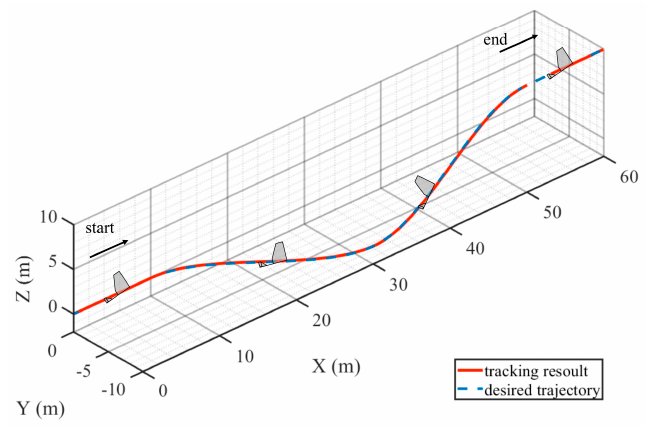
Figure 12. The 3D trajectory tracking results. From Figures 12 and 13, it can be seen that the tracking trajectory of the RAMPC matches the desired output trajectory very well. The maximum error in the X-axis and Z-axis displacement tracking is not more than 0.2 m, and the minimum error is in the X-axis tracking, with approximately 0.05 m, resulting in a great tracking effect. Figure 14 shows the curve of the attitude angle and actuator output of the CWMAV during trajectory tracking flight. Based on the mechanism of attitude control and attitude angle solving Equations (12)–(14), it can be found: (1) in the turning stage ( t = 5 ∼ 15), the yaw actuator and flapping frequency can work to provide roll and yaw torques; (2) in the climbing stage ( t = 15 ∼ 25), the pitch actuator and flapping frequency change to provide the pitch torque; (3) in the decelerating stage ( t = 25 ∼ 30), the amplitude of the flapping frequency decline is smaller than that of the accelerating stage, which is due to that a larger incoming flow speed could provide more